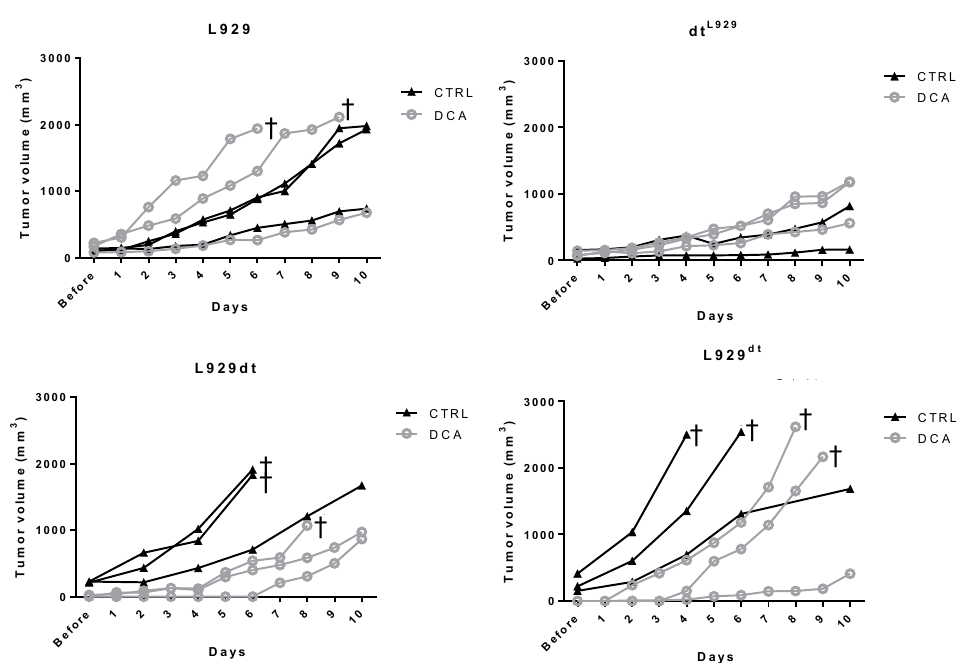
Figure 10. In vivo effect of DCA. 1 × 10 6 L929, L929dt, L929dt L929 or L929 dt living cells were injected s.c., respectively, in groups of 6 mice each. When the tumor began to be detectable (20 mm 3 ), each experimental group was divided in two, and three mice received intratumoral injections of 50 µL PBS every day during 10 days (Control, CTRL; black triangles) while the other three mice received injections of 25 mM DCA in 50 µL PBS with the same time schedule (DCA; grey circles). Data show tumor size during the 10 days of the treatments for each individual mouse. † indicates the sacrifice of mice due to ethical reasons before the end of the 10-day period.